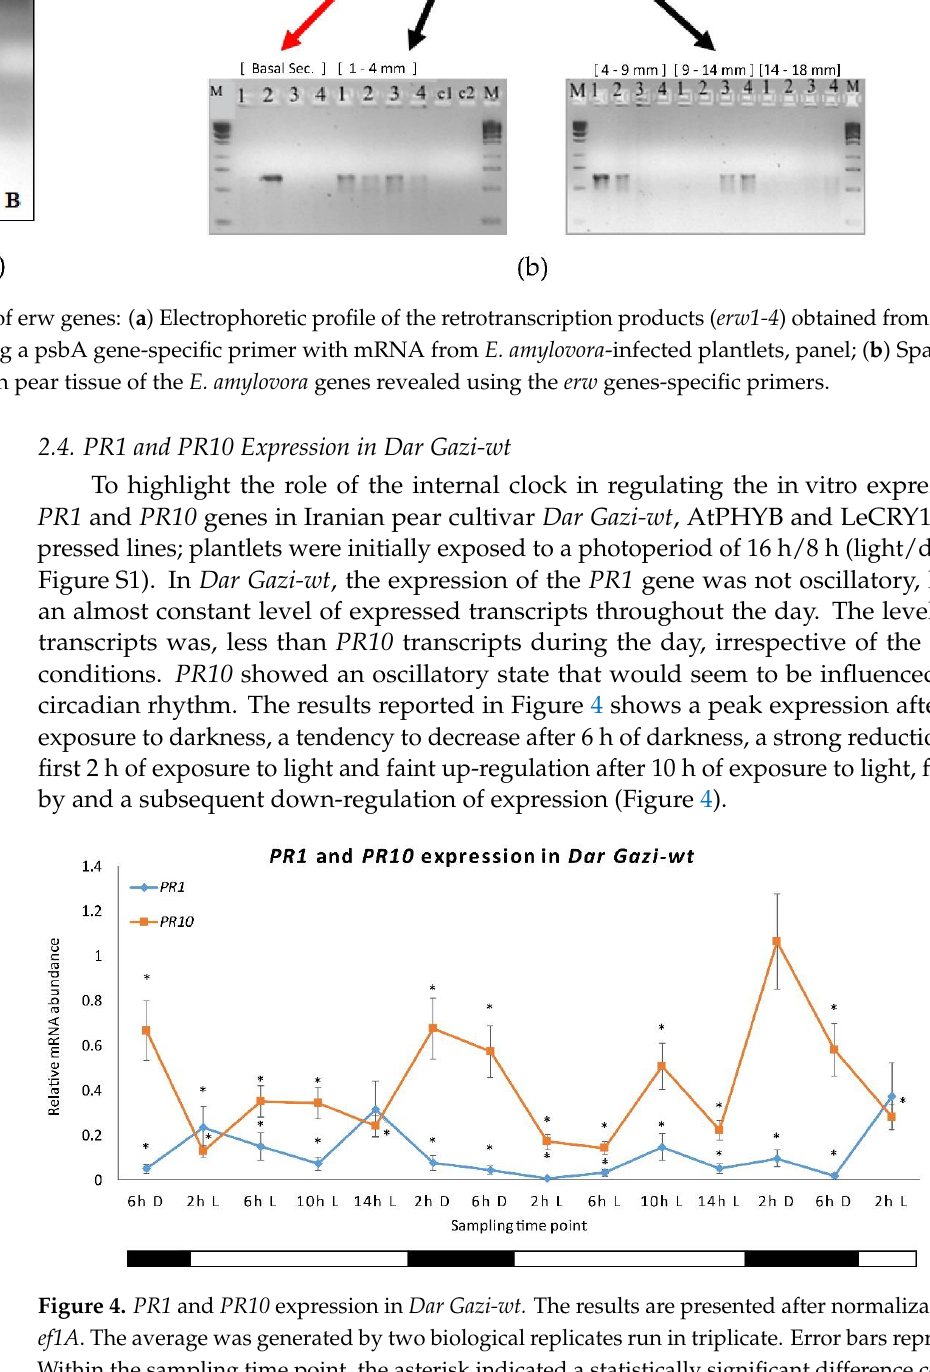
Figure 5. PR1 and PR10 expression in Dar Gazi-wt plantlets: ( a ) in 24 h continuous light (WL); ( b ) in 24 h continuous darkness. The results are presented after normalization with ef1A . Data shown as the average of two biological replicates run in triplicate, with error bars representing SD. For each single gene expression pattern, values with different letters significantly differ according to the analysis of variance (ANOVA) and least significant difference (LSD) tests ( p ≤ 0.05). Uppercase and lowercase letters are referred to as PR1 and PR10 , respectively. 2.5. PR1 and PR10 Expression in CRY1 and PHYB Overexpressing Lines in WL Data for the PR1 expression in the plantlets of Dar Gazi-cry1 line indicate that the photoreceptor CRY1 plays a role in the regulatory system of this gene (Figures 6 and S3). Under darkness, in the plantlets of this line, the detected transcripts increased up to 3 times those detected in the plantlets of Dar Gazy-wt. Moreover, a semi-oscillatory rhythm would seem to be evocated by the increased presence of CRY1 in the plantlet tissues, strongly upregulating the expression of PR1 . From these results, it was evident that BL plays a role as overexpressed CRY1 emphasizes this aspect. The role of RL turns out to be different than that of BL, as can be seen in the plantlets of the PHYB-overexpressing line (Figure 6). The peak expression of PR1 during the darkness period was approximately 8- fold greater in the transformed lines relative to the wt-line, comparable to that detected in the plantlets of the Dar Gazi-cry1 . During the light period, the behavior of gene expression